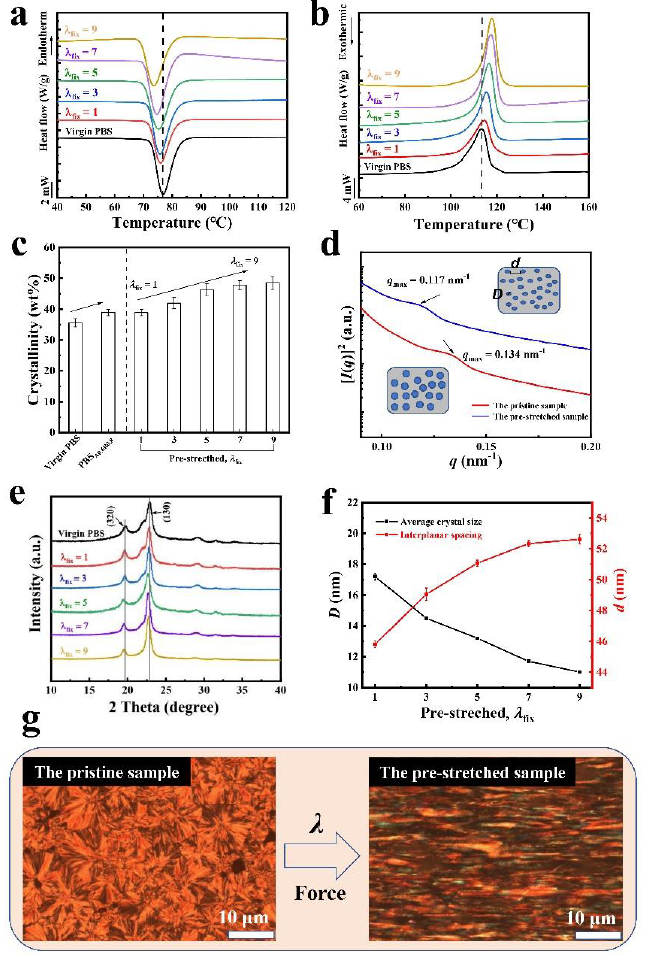
Figure 4. Characterization of crystalline domains in PBS. ( a , b ) Representative DSC curves for crystallization and melting of the various pre-stretching states, with pre-stretch ratios. ( c ) Measured crystallinity in virgin PBS, chain-extended PBS and pre-stretching states with pre-stretch ratios. ( d ) SAXS profiles of the pristine sample and the pre-stretching sample with q max values extracted from the [ I ( q )] 2 ~ q curve. ( e ) Representative WAXS profiles of virgin PBS and various pre-stretching states with pre-stretch ratios of λ fix = 1, 3, 5, 7 and 9. ( f ) Estimated the average distance between adjacent crystalline domains d and average crystallite sizes perpendicularly across the planes D of pre-stretching states with pre-stretch ratios. ( g ) PLOM phase images of the pristine state and the pre-stretching state (scale bar = 10 µ